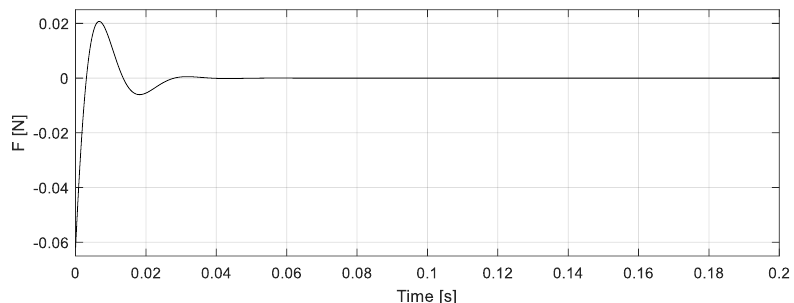
Figure 17. Force acting on the harvester due to a drop impacting on a thin water layer. The voltage generated by the harvester excited by this force is represented with a blue line in Figure 18. The same figure represents the measured voltage with a red line. Comparing the FFT diagrams of the two signals (Figure 18b), it is apparent that the simulated voltage correctly matches the oscillation frequency. The time histories of the simulated and experimental voltage in Figure 18a are very similar. In particular, the simulated voltage correctly represents both the amplitude increase with respect to the dry spoon model and the voltage waveform, i.e., the first peak is smaller than the second, as in the experimental results.